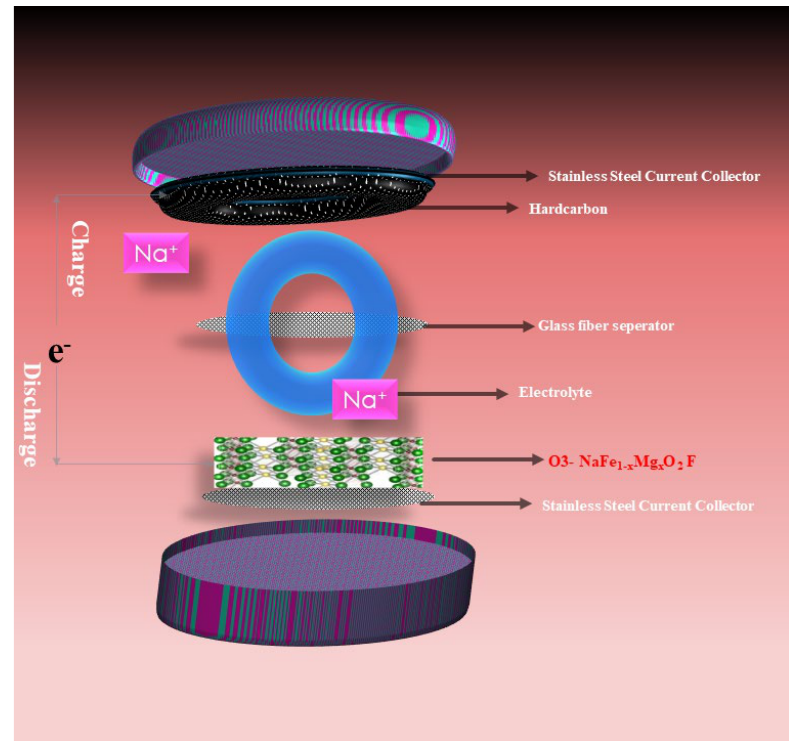
Figure 9. Schematic showing of electrodes’ arrangements in a coin cell.